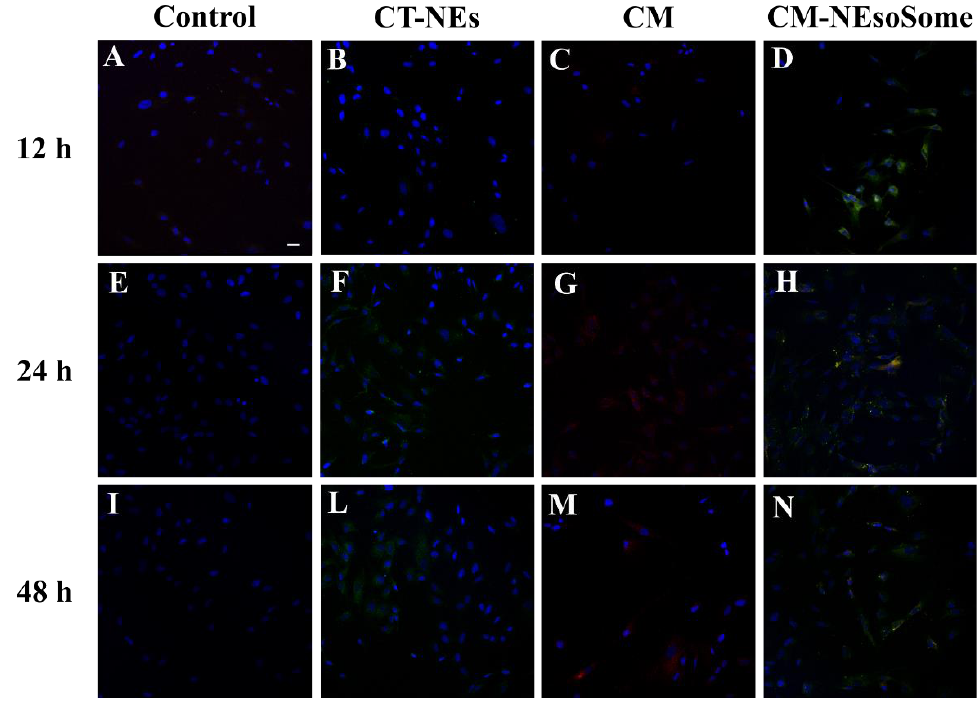
Figure 5. Confocal images of HDF uptake of cell medium alone ( A , E , I ), CT-NEs ( B , F , L ), CM as is ( C , G , M ) and CM-NEsoSomes ( D , H , N ) after 12, 24 and 48 h of incubation. Scale bar 30 μm.